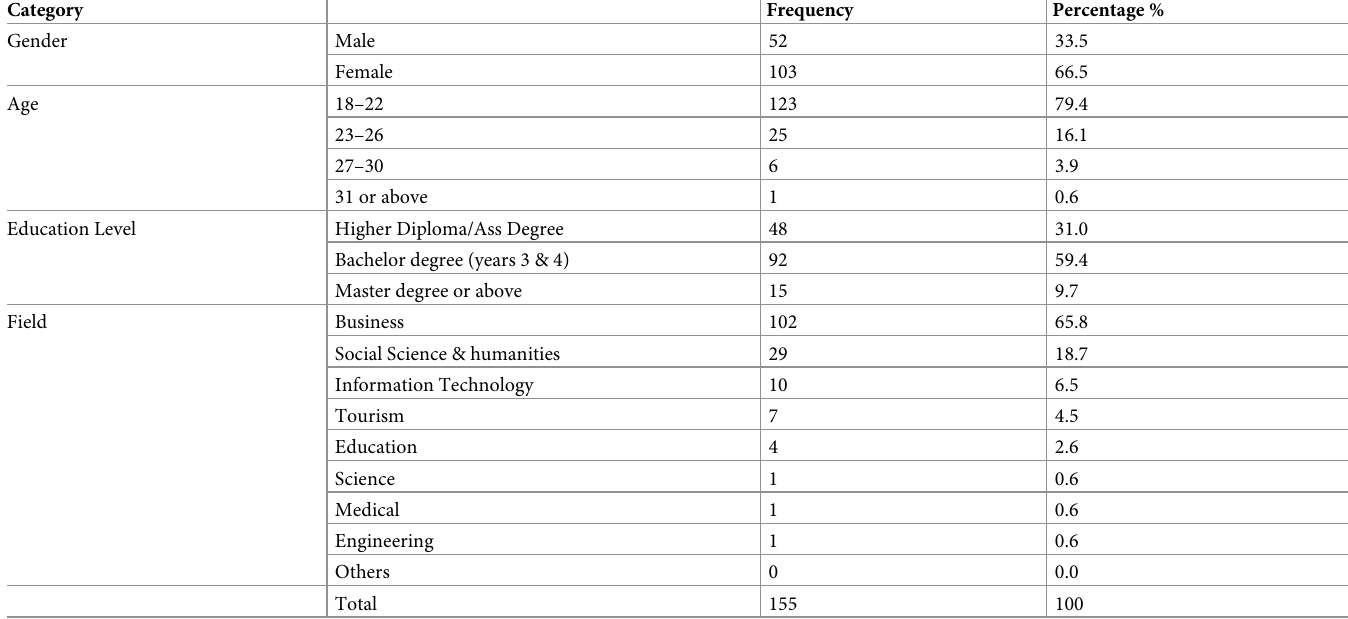
Table 2. Demographic data of respondents.